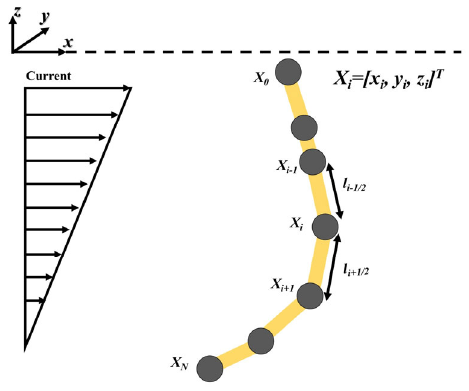
Figure 8. Schematic diagram of discretization and indexing.